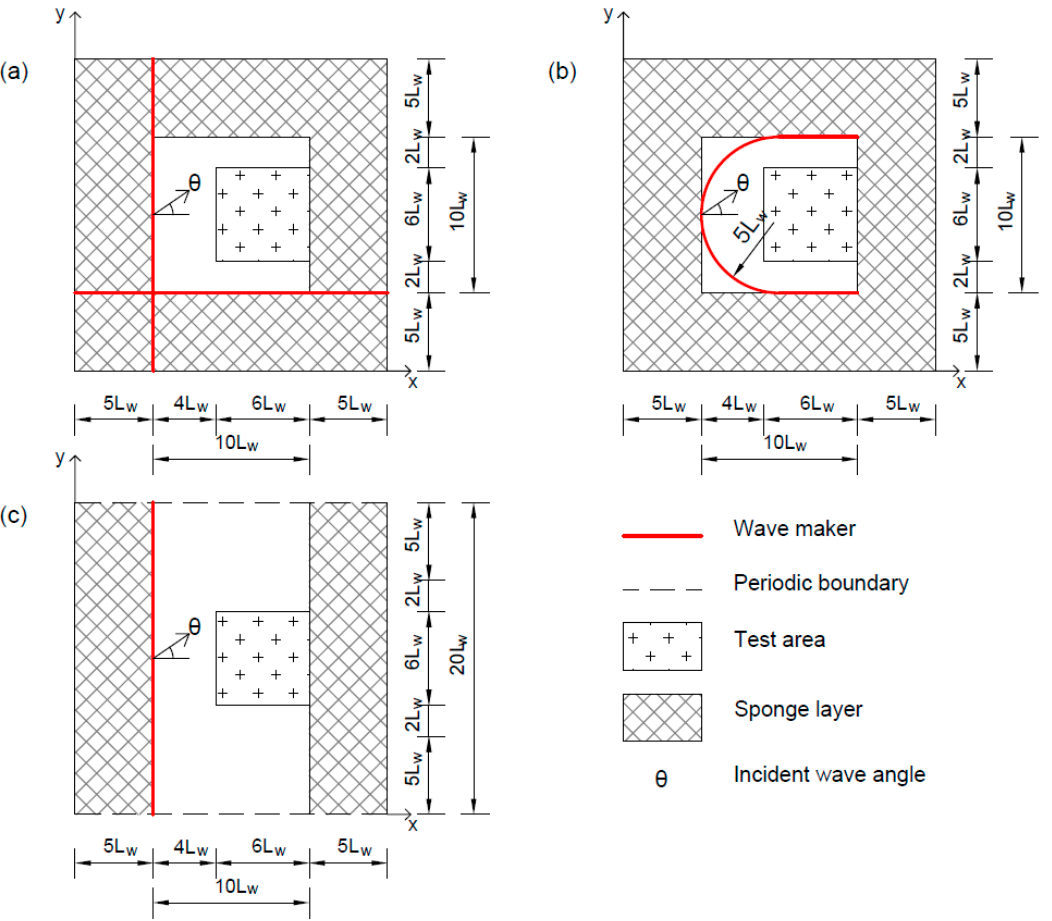
Figure 4. Definition sketch of three wave generation layouts: ( a ) L-shaped, ( b ) arc-shaped, ( c ) line-shaped with periodic lateral boundaries. Dimensions are expressed in the number of wave lengths, L w = 100 m, which corresponds to a wave period, T = 12 s, and water depth, d = 7.5 m.